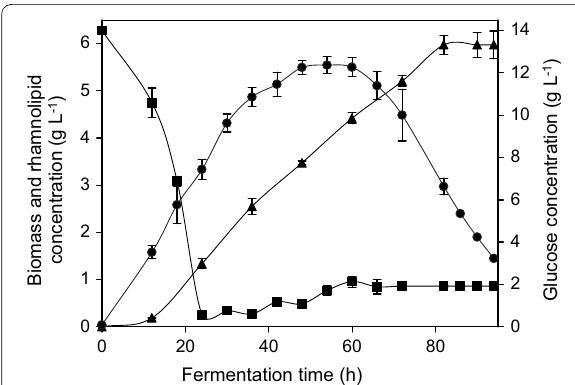
Fig. 3 Time course of overall biomass, glucose and rhamnolipid concentrations during cultivations of integrated fermentation are shown. Feed was started at time 24 h. Values of biomass (circles), glucose (squares) and rhamnolipids (triangles) concentrations of two integrated cultivations are given as mean